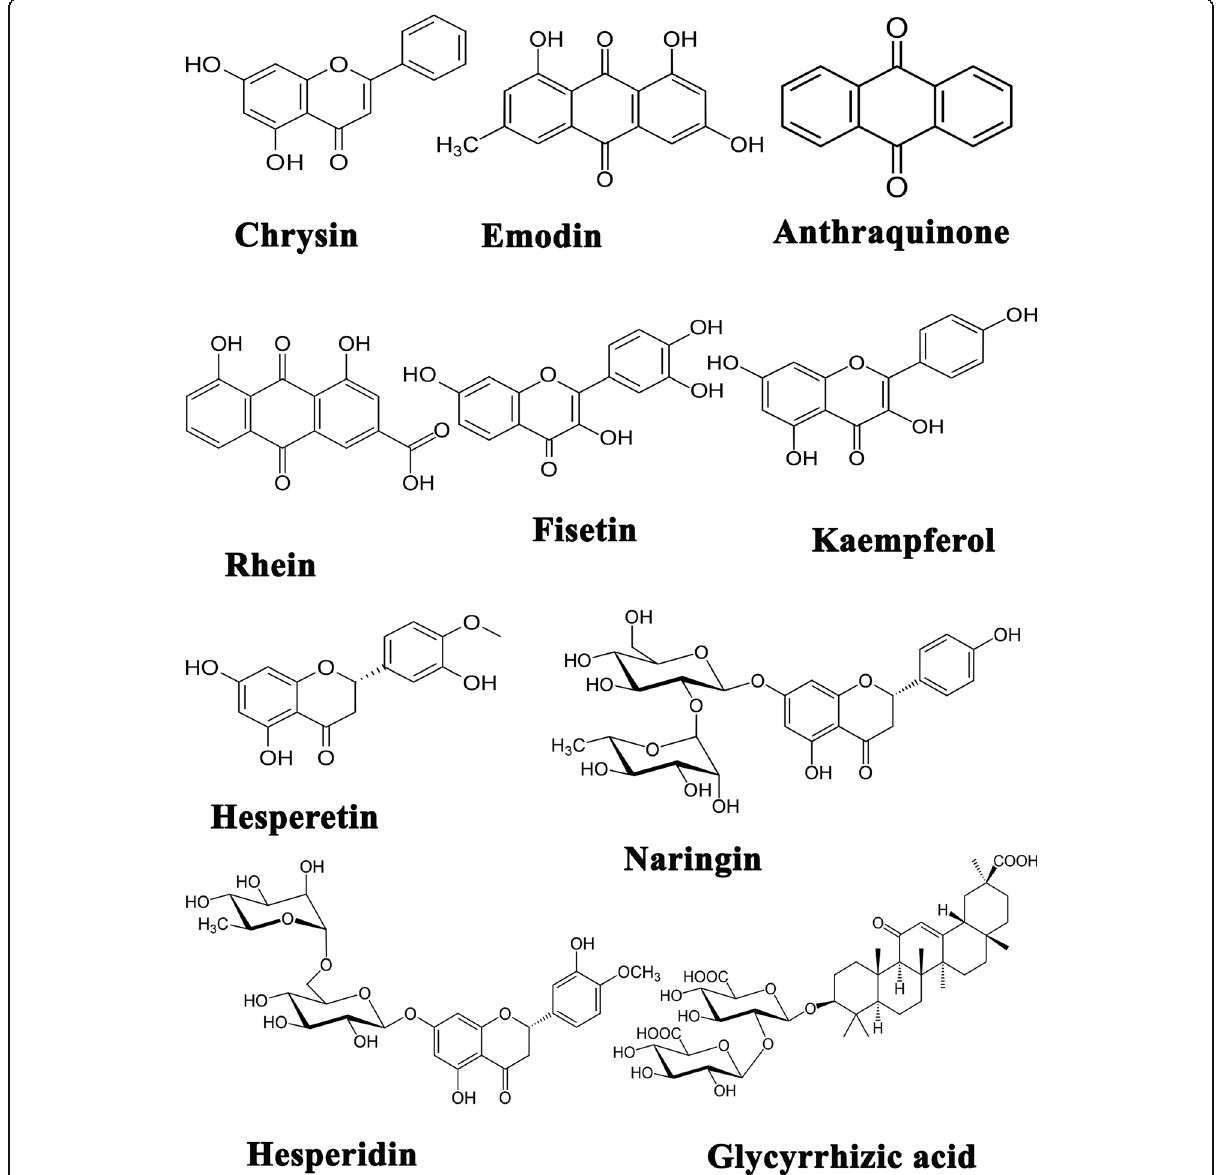
Fig. 3 Antiviral flavonoids suggested as spike-ACE2 complex